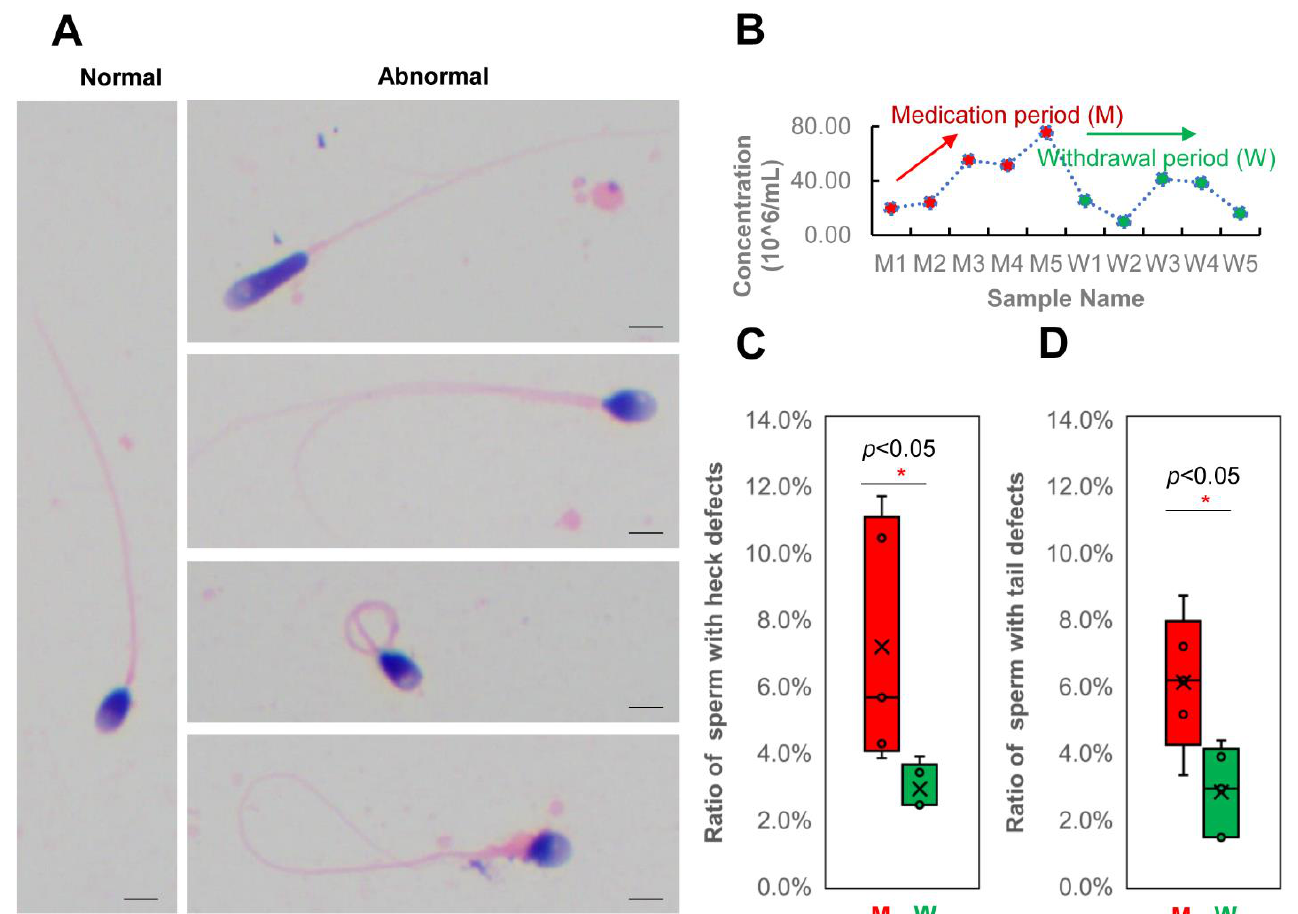
Figure 3. Semen examination and morphological analysis of human sperm after antibiotic therapy.